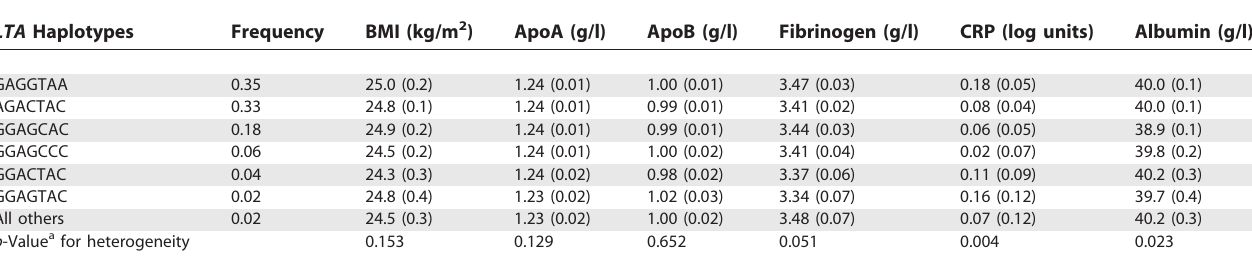
Table 4. Mean (SE) Values for Selected Characteristics by Haplotypes for the LTA Gene in